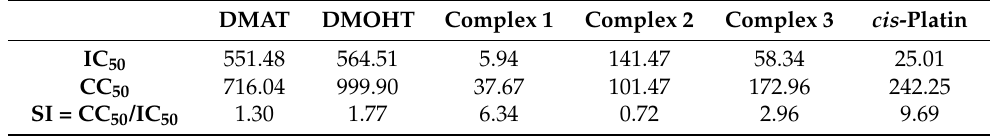
Table 8. IC 50 , CC 50 and selectivity index (SI) values ( µ M) for the studied